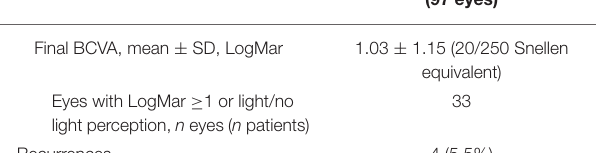
TABLE 1 | Demographic, clinical features, diagnostic work-up, treatment, and outcome of the 72 pediatric patients with ARN collected by literature review and analysis of our center